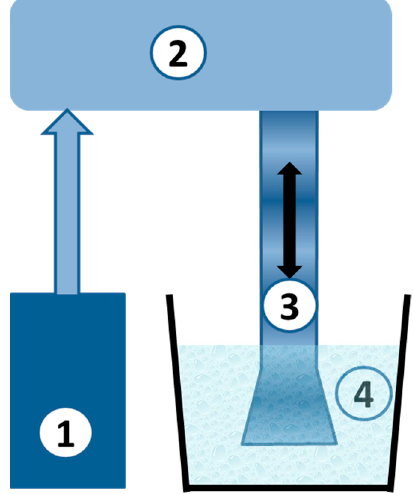
Figure 1. Scheme of the ultrasound device. 1—ultrasound generator, 2—magnetostrictive transducer, 3—waveguide, 4—vessel with water.